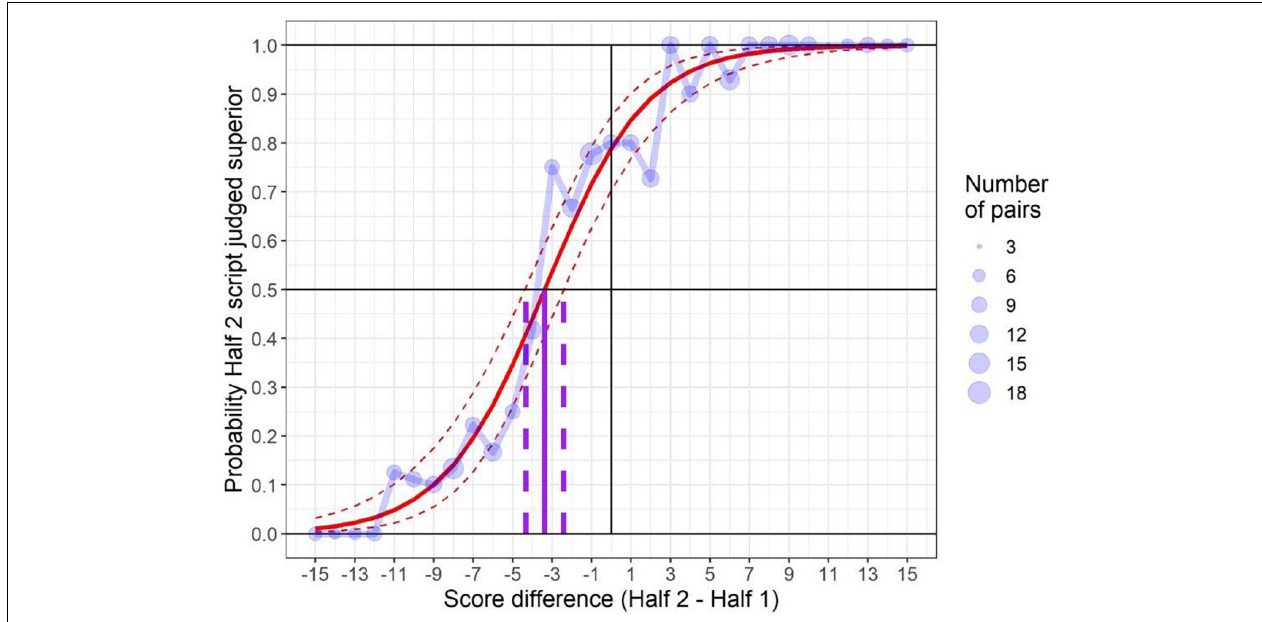
FIGURE 2 | Graphical depiction of the results of using simplified pairs to gauge the relative difficulty of two assessment versions (mathematics).